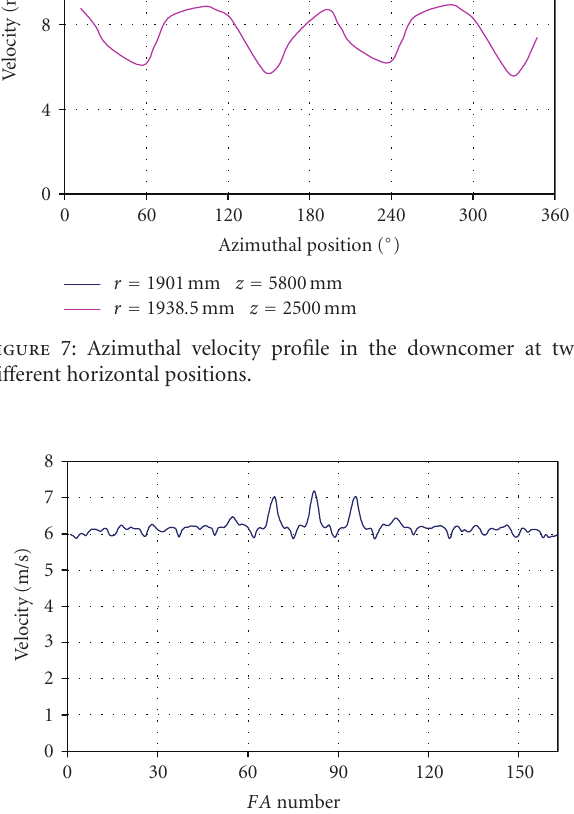
Figure 8: Velocity distribution at the core inlet over the fuel element positions.